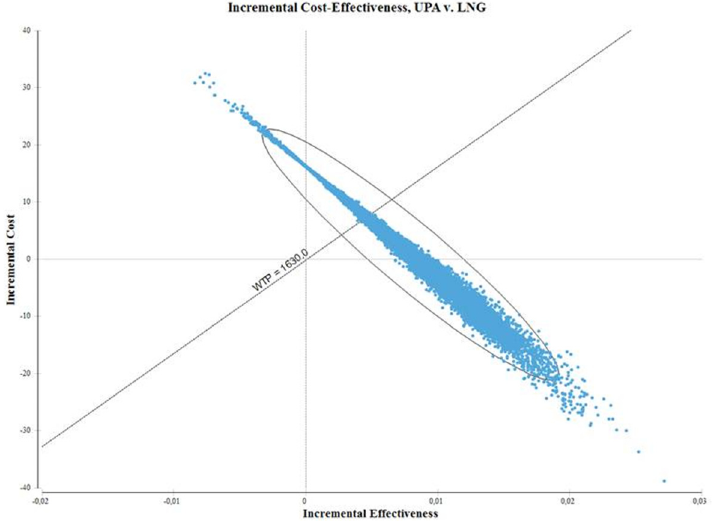
Fig 3. Cost-effectiveness plane of ulipristal acetate versus levonorgestrel (intake within 72 hours). WTP, willingess-to-pay, defined as the cost of an unintended pregnancy; UPA, ulipristal acetate; LNG, levonorgestrel. Note: in the upper-right quadrant, UPA costs more and is more effective than LNG; in the lower-right quadrant, UPA costs less and is more effective. UPA is cost-effective for all iterations below the WTP